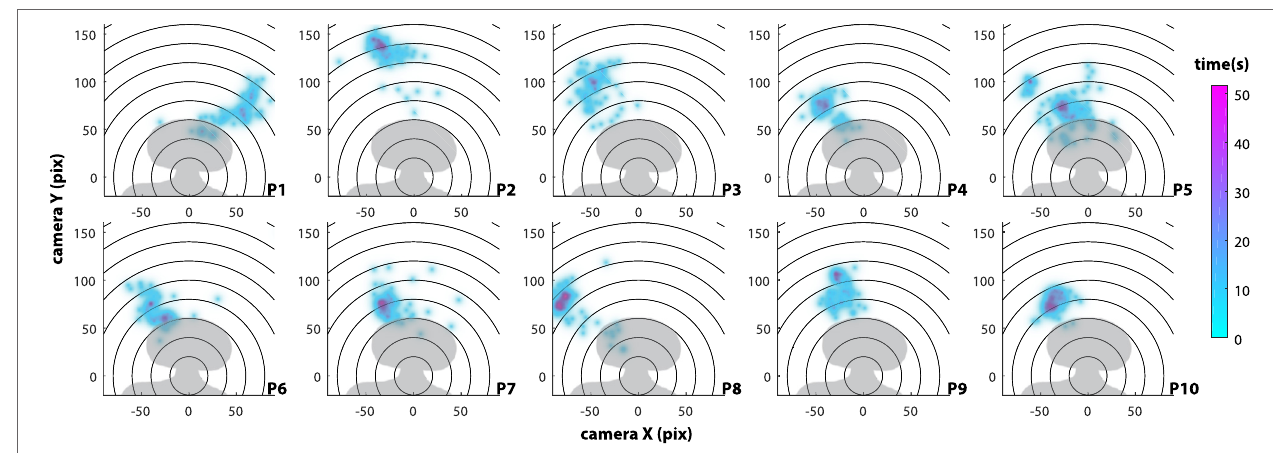
FigUre 9 | Representation of all children’s motion in Opie’s peripersonal space (in pixels, measured on the image extracted from the camera overlooking the scene). Colored areas represent the time spent in each location (in